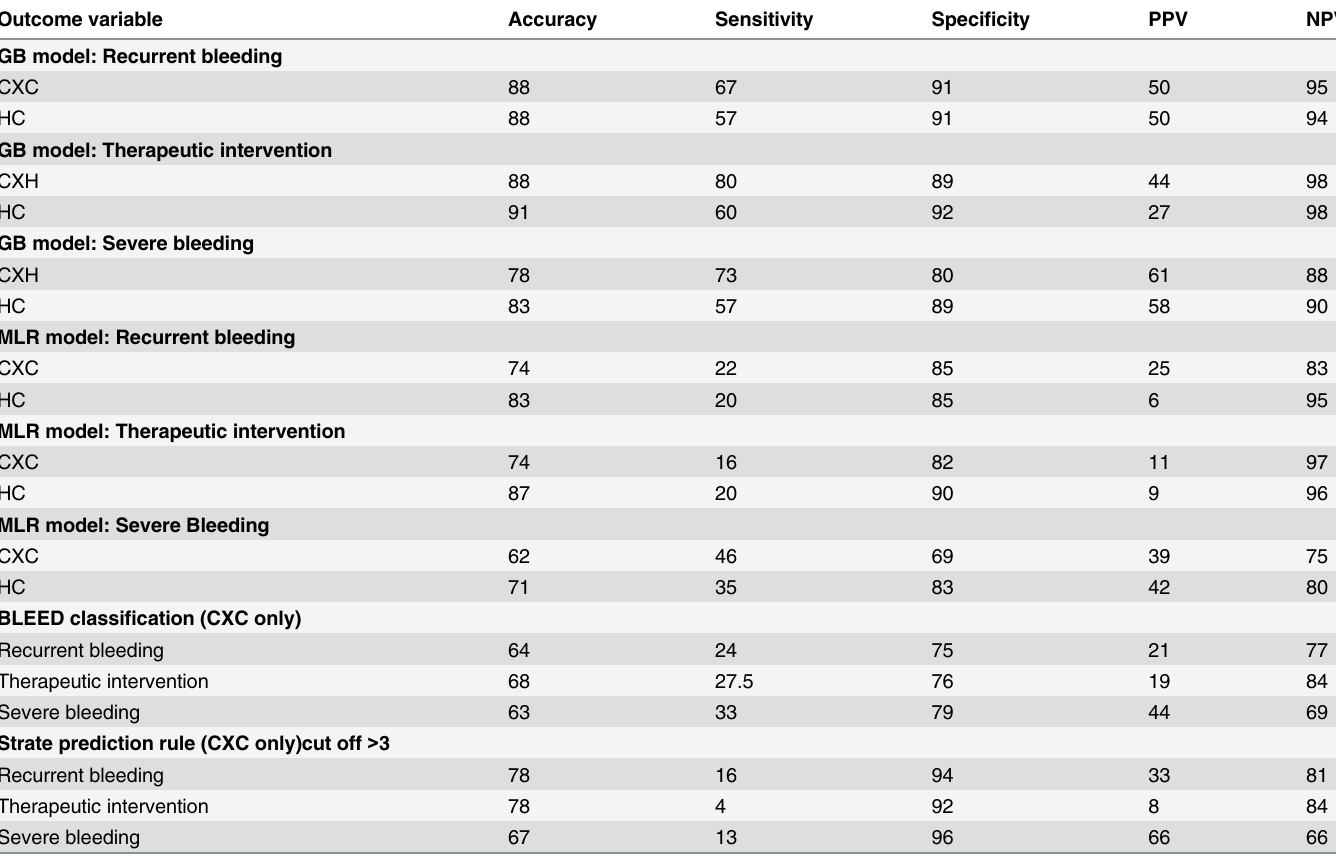
(Table 4) for recurrent bleeding, therapeutic intervention and severe bleeding respectively. The accuracies were similar in the Charing Cross and Hammersmith cohorts. The positive predic- tive value of all GB algorithms were not high in either cohort although importantly for clinical decision making the negative predictive values were high (88 – 98%) for the three outcomes. Table 4. Predictive performance of models in Charing Cross (CXC) and Hammersmith (HC) cohorts. Outcome